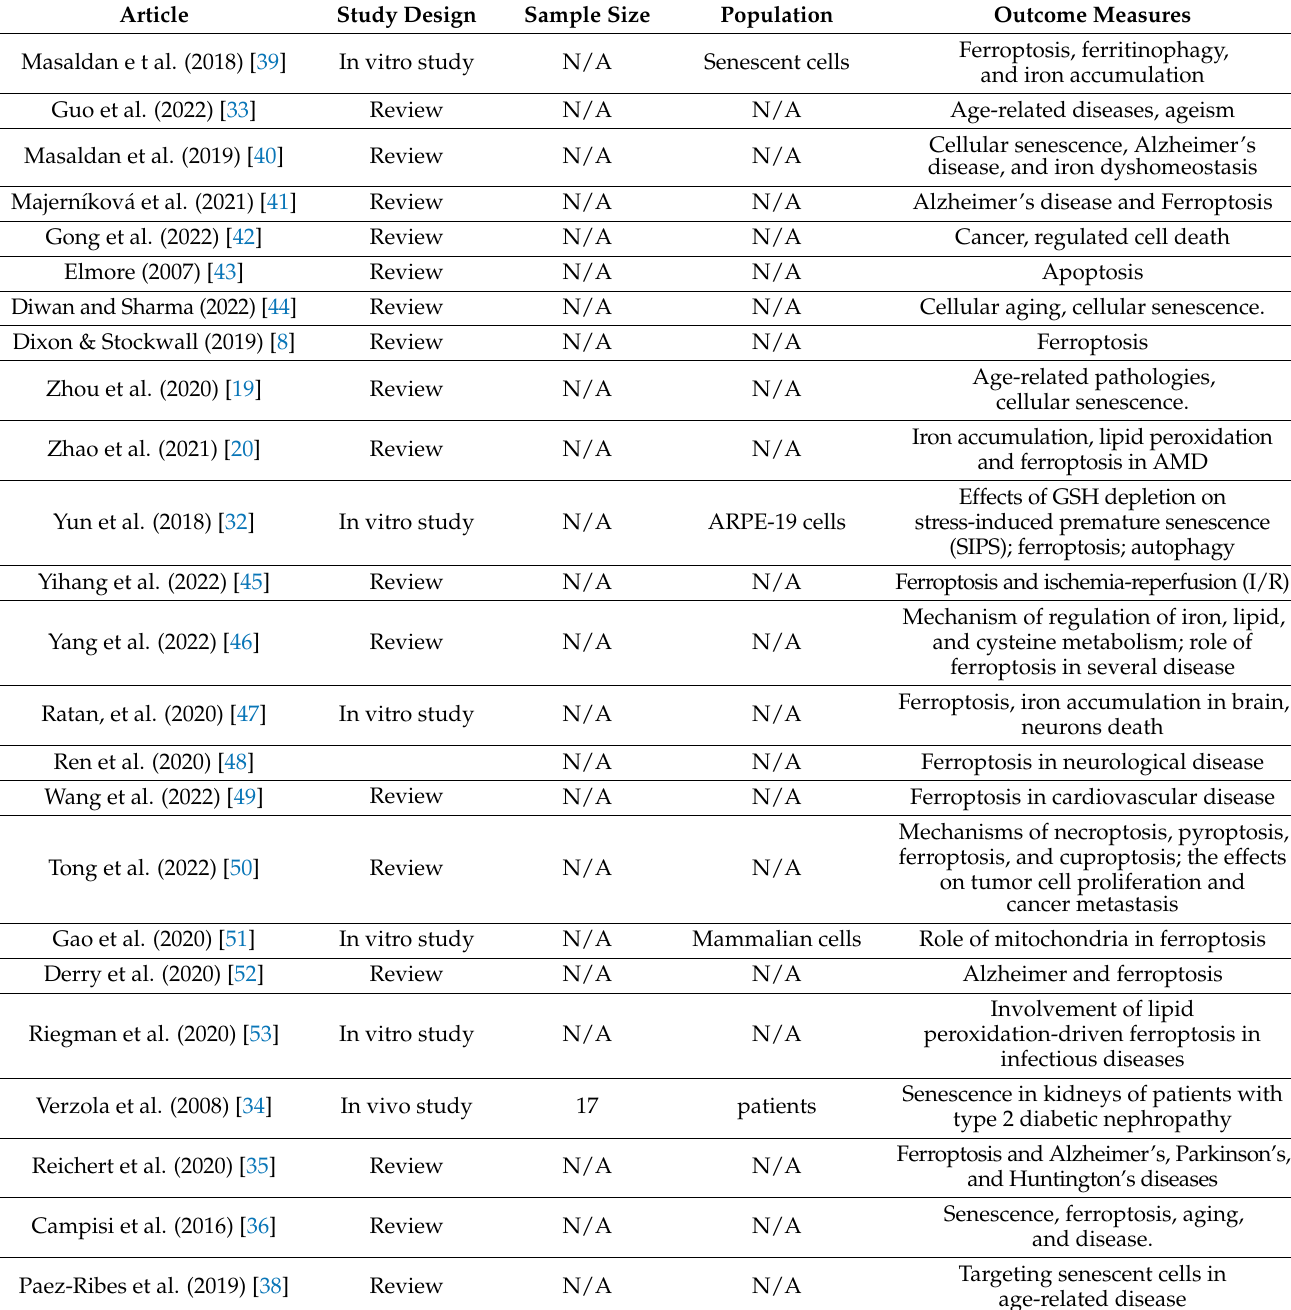
Table 1. This table summarized the article’s data and